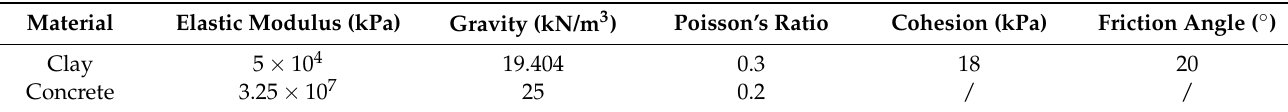
Figure 3. Structural model of unequal-span subway station. ( a ) Three-dimensional model of the subway station. ( b ) Section of the subway station. Table 1. Values of